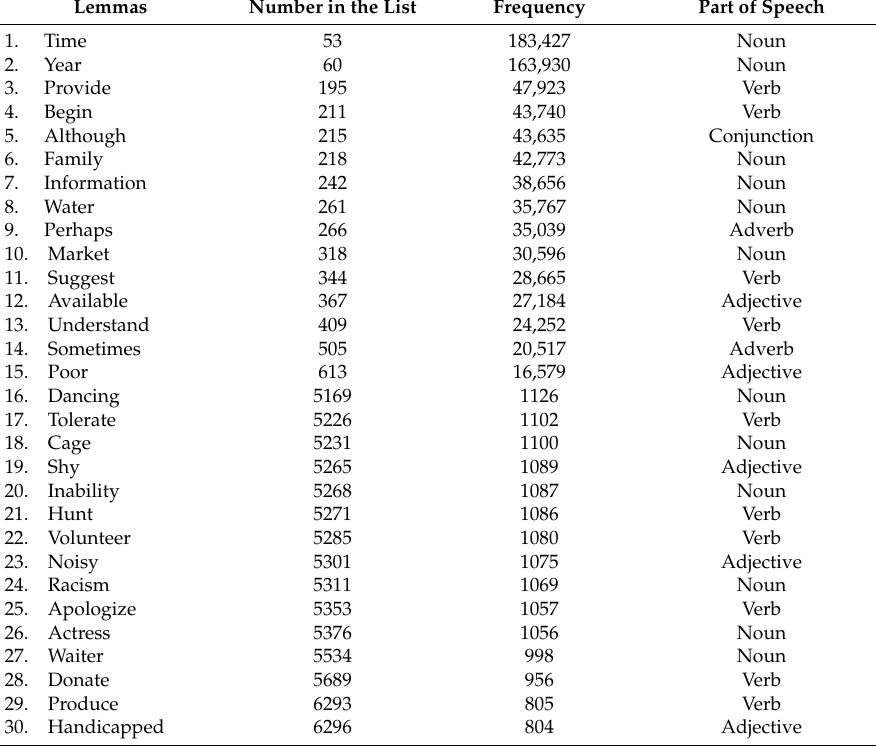
Table 1. Details of the words used in the receptive vocabulary knowledge